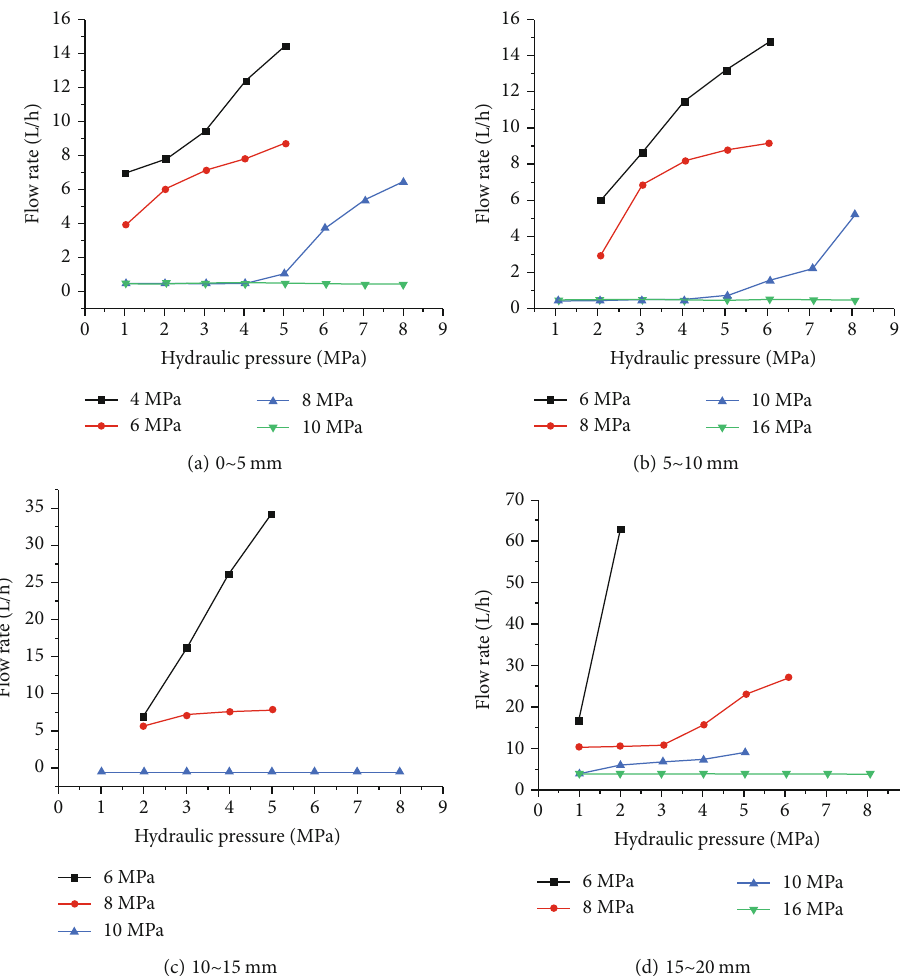
Figure 6: Relations between the fl ow rate and hydraulic pressure for the fi lling gangues with di ff erent size